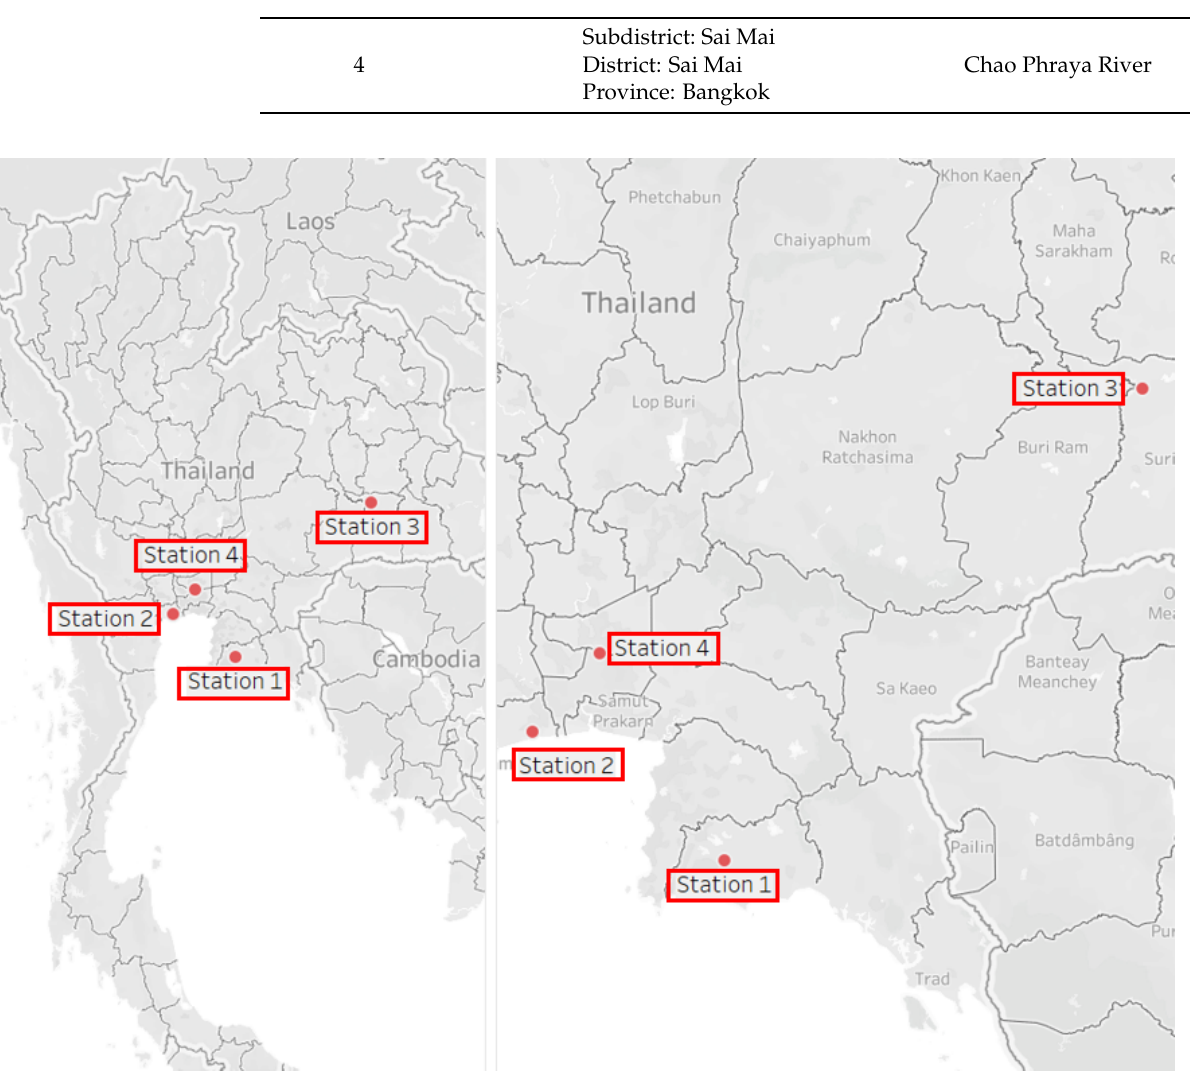
Figure 5. Locations of the selected stations at a country level ( left ) and at a specific zoom-in level ( right